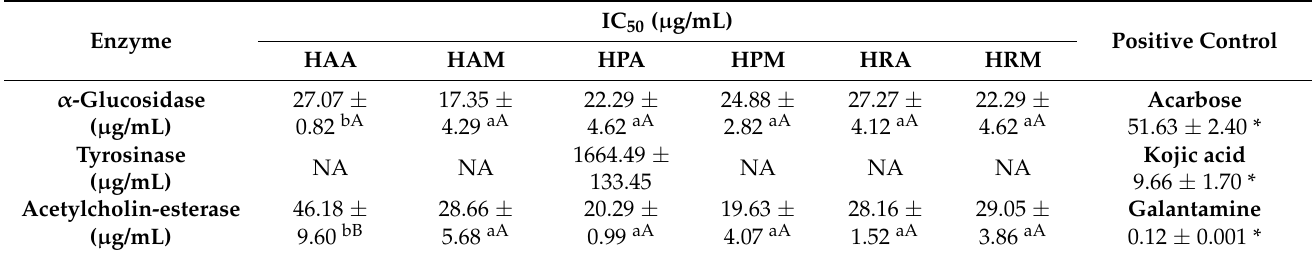
Table 3. Overview of in vitro enzymatic inhibition potential of Hypericum extracts.